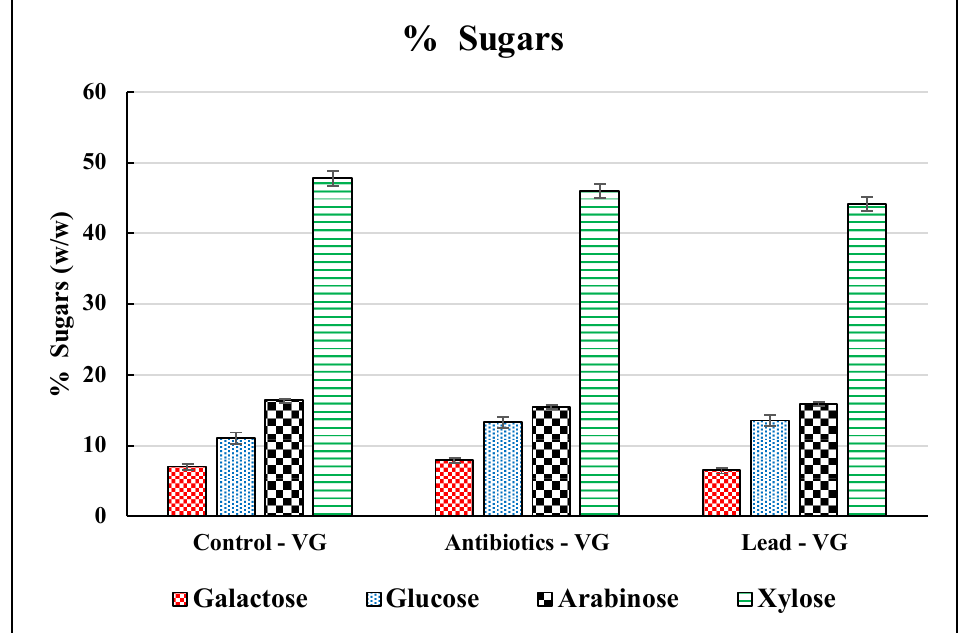
Figure 3. Reducing sugars in different sources of VG .